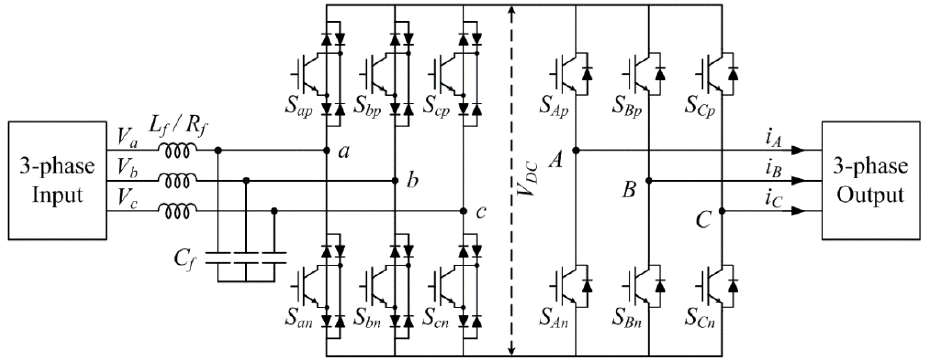
Figure 3. Topology of the very sparse matrix converter.